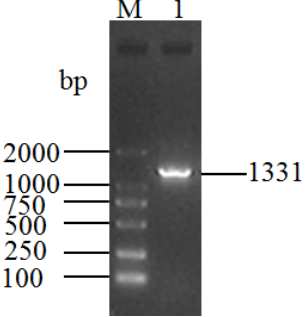
Figure 1. RT-PCR fragment of water buffalo DGAT2 gene. M, Marker-DL2000; 1, sample